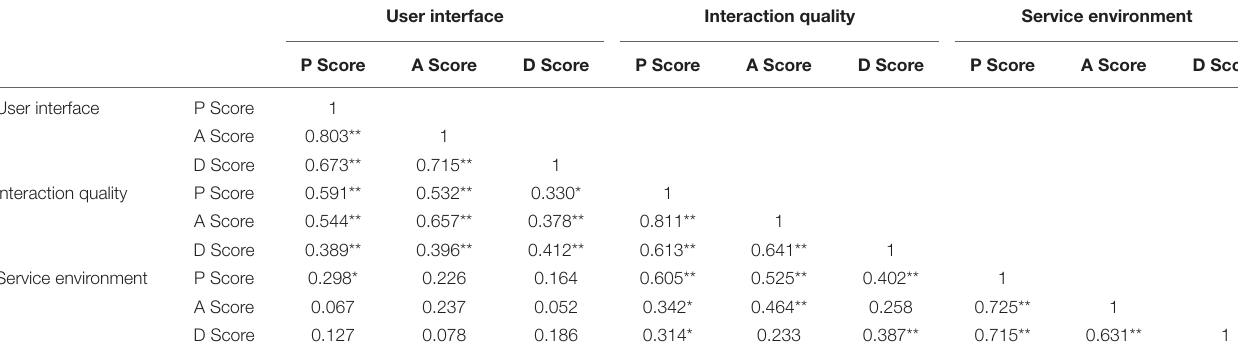
TABLE 4 | Correlation among P-A-D Scores of the user interface, the interaction quality, and the service